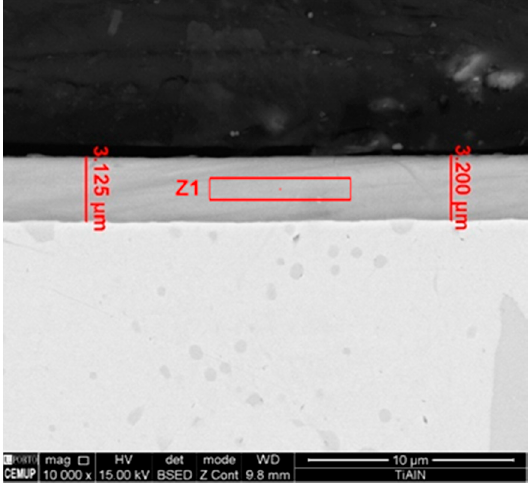
Figure 5. SEM micrograph of TiAlN film cross section with corresponding thickness measurements.